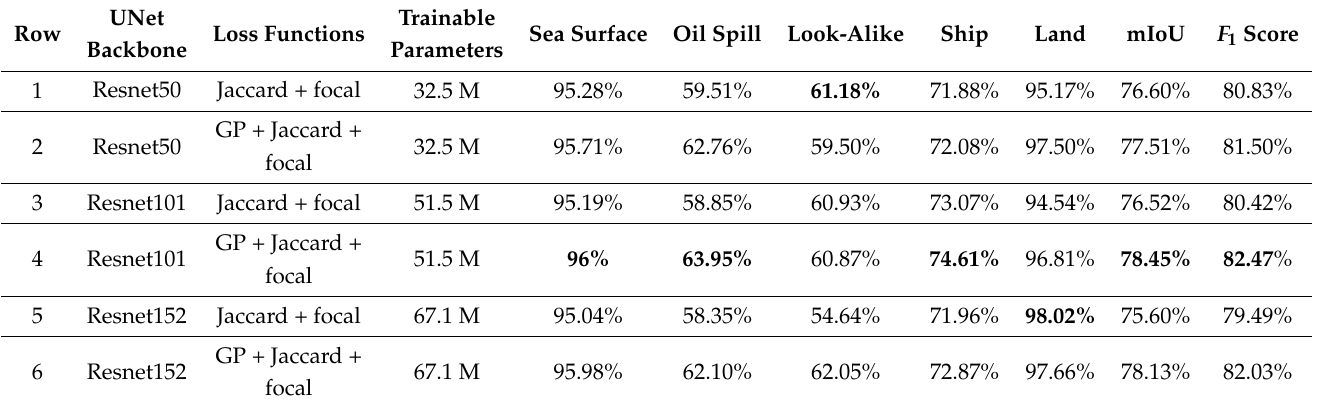
Table 3. Ablation on different resnet backbones and different loss functions, evaluated over the test SAR images in terms of the IoU and F 1 scores.